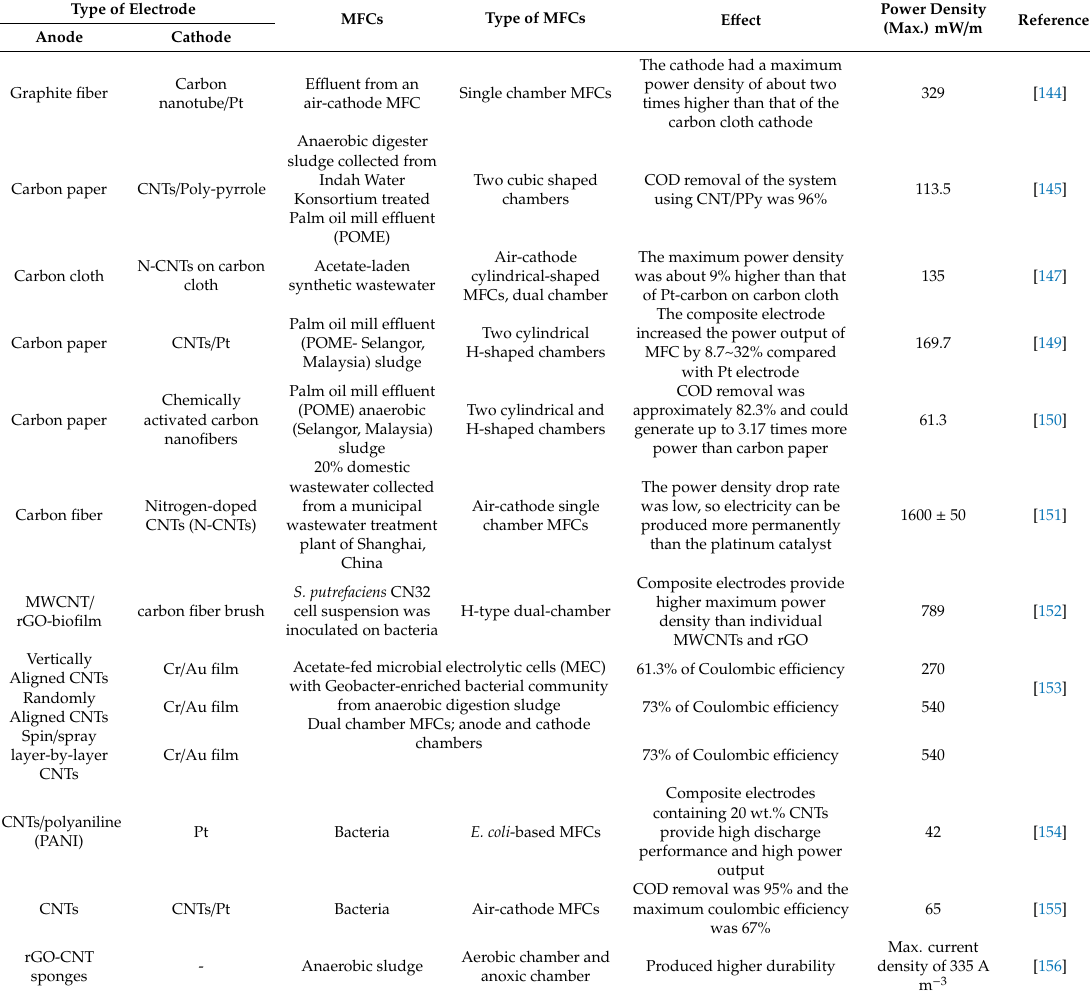
Table 8. The e ff ects of the carbon-based electrode on microbial fuel cells (MFCs). Type of